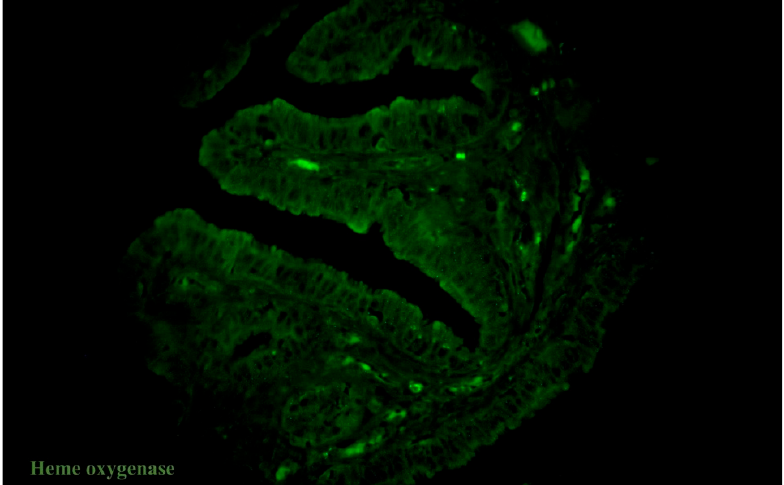
Figure 2. Tissue sample of human oviduct stained for HO-1 (green, Alexa Fluor 488) in the patient with uterine myoma. Total magnification: ×400.